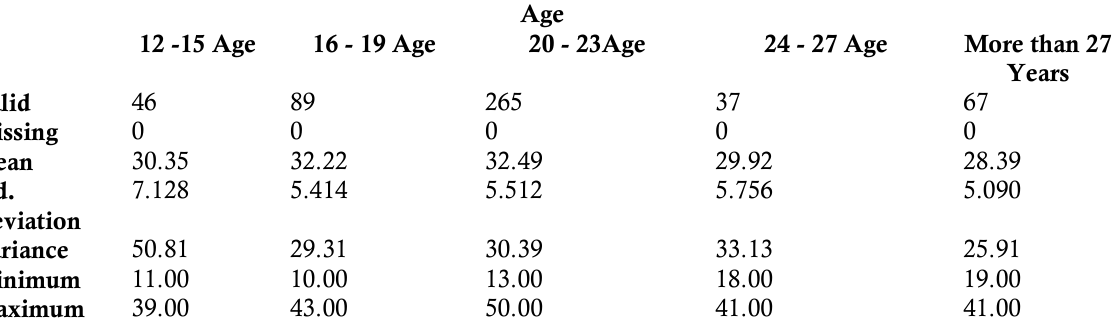
Table 4. Descriptive Statistics loneliness based on age